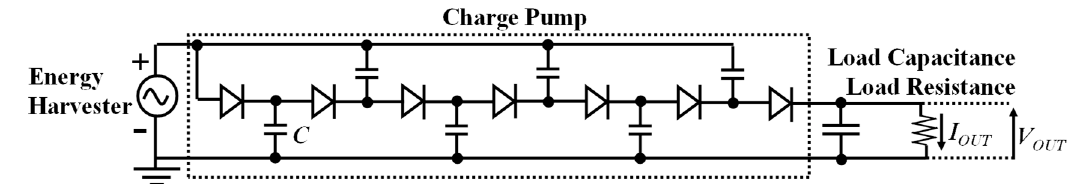
Figure 1. AC-DC charge pump (CP) [8].